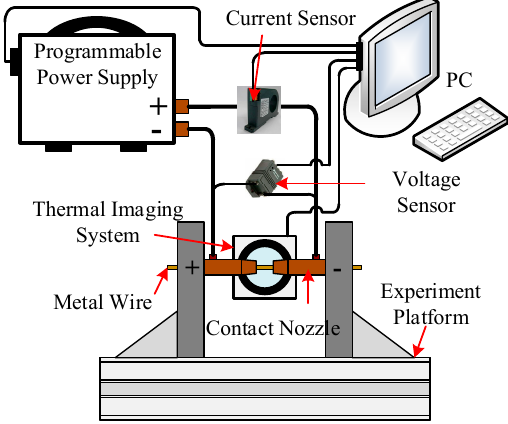
Figure 4. Resistance heating single and double metal wire experimental system.